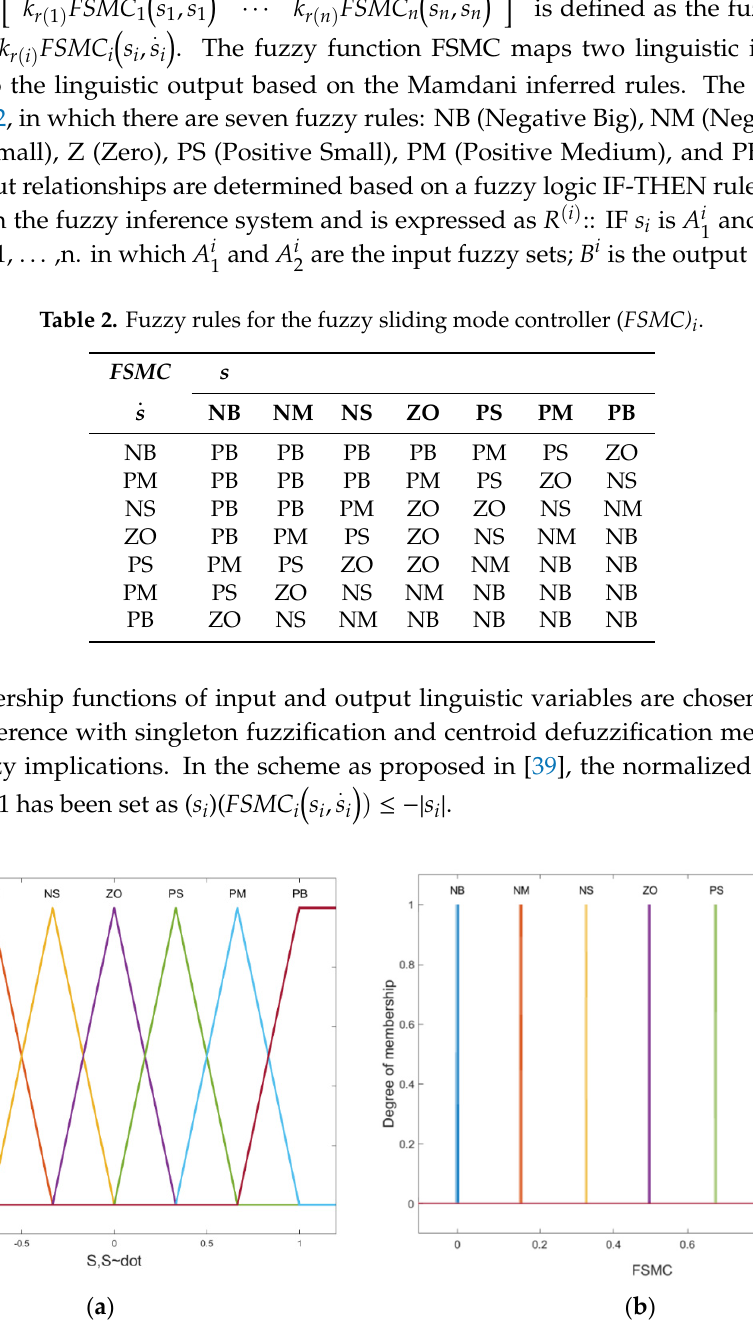
Figure 6. Membership function of the assignment of the fuzzy set for ( a ) input variables (𝑠 (cid:3036) , 𝑠 (cid:4662) 𝑖 ) ; ( b ) output variable 𝐹𝑆𝑀𝐶 (cid:3036) .